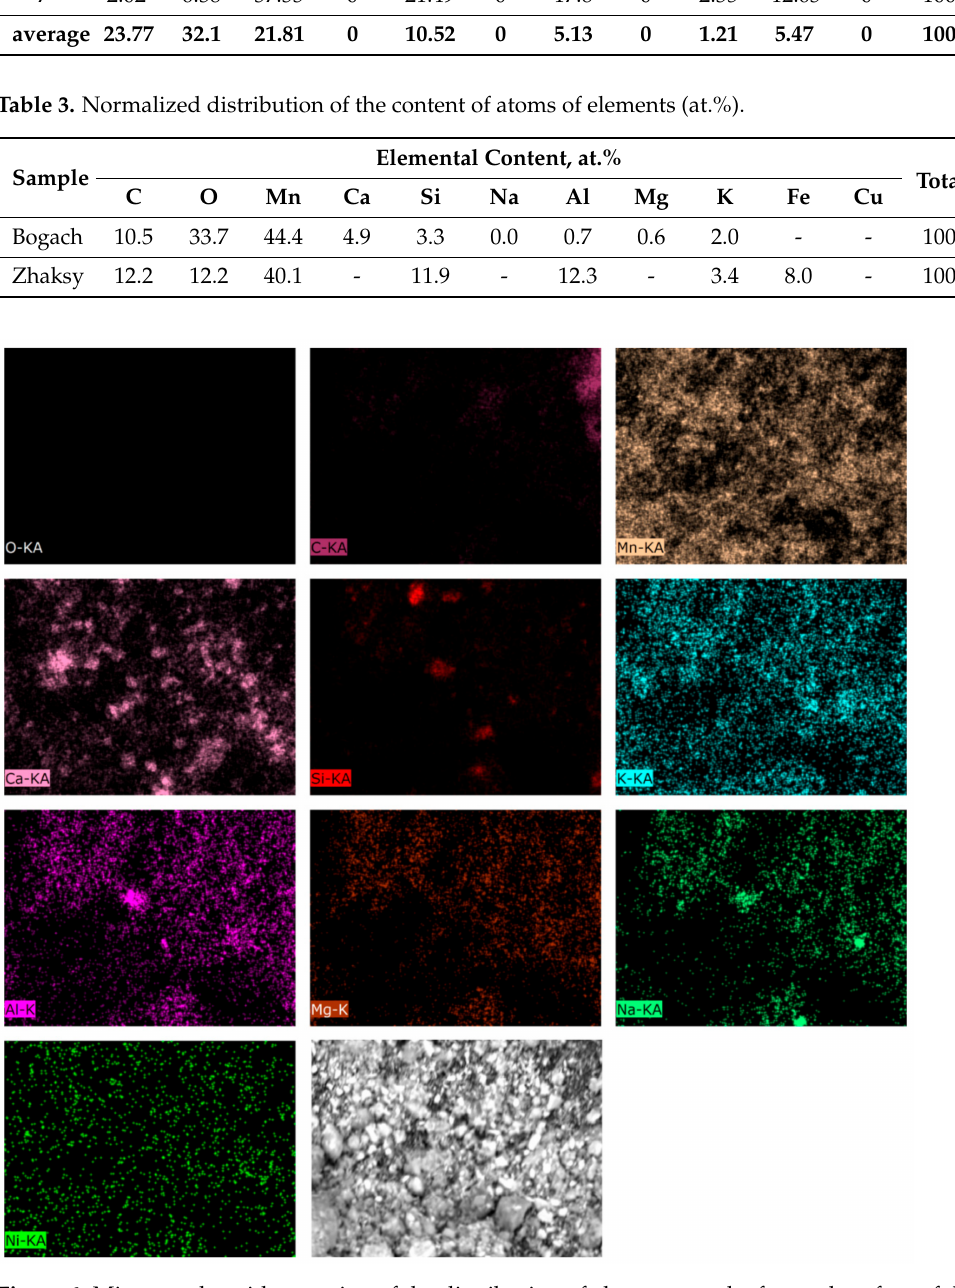
Figure 6. Micrographs with mapping of the distribution of elements on the focused surface of the manganese ore sample from the Bogach